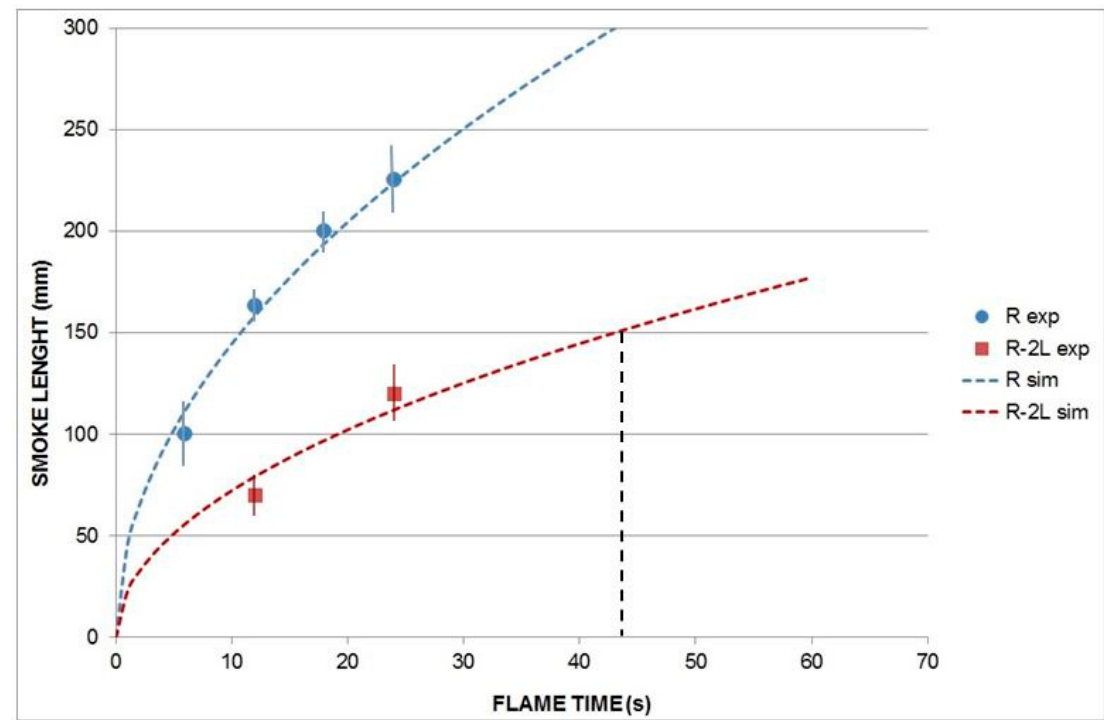
Figure 4. Flammability test: smoke length versus flame-time for Radel R material, experimental data and physical optimized modeling results.